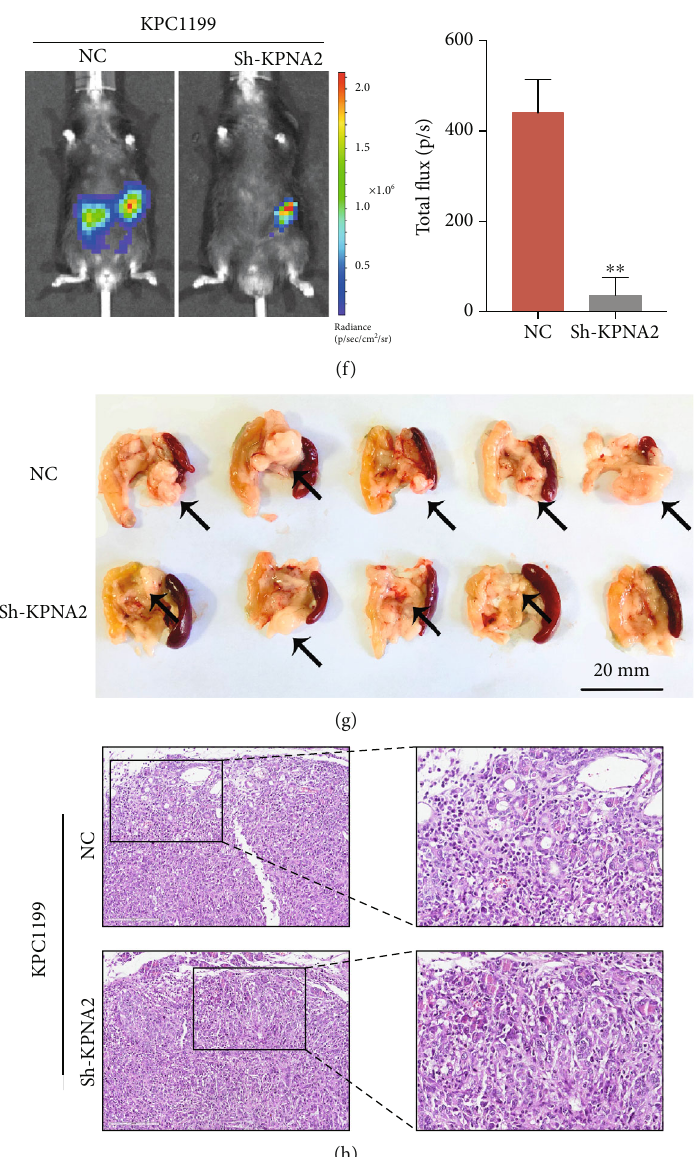
Figure 2: KPNA2 knockdown inhibited the growth of PDAC cells in vivo rather than in vitro . (a, b) KPNA2 silencing by sh-RNA-KPNA2 in MIA PaCa-2 and PANC-1 cells. (c) CCK8 assays of the control group and KPNA2 knockdown group of MIA PaCa-2 and PANC-1 cell lines. (d) Wound healing assays of the control group and KPNA2 knockdown group of MIA PaCa-2 and PANC-1 cell lines. (e) KPNA2 silencing by sh-RNA-KPNA2 in KPC1199-luc cell. (f) Bioluminescence imaging and luminescence intensity of orthotopic tumor growth. (g) Pancreas of C57BL/6N mice orthotopically transplanted stable KPNA2-knockdown KPC1199-luc cells and control cells. (h) Representative images of H&E staining of orthotopic PDAC model mice at 21